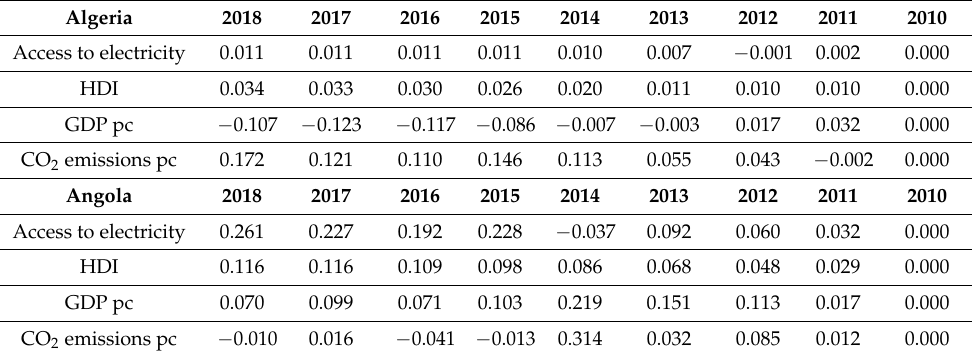
Table 6. The results of the second stage of standardization for model (b) for two selected African countries. Source: own